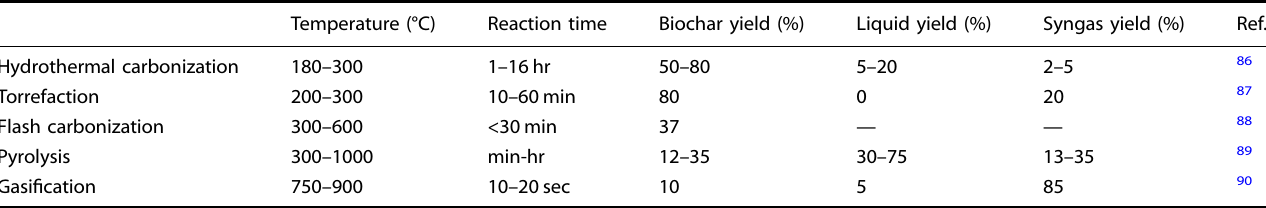
Table 2. Thermochemical conversion techniques and their process conditions.